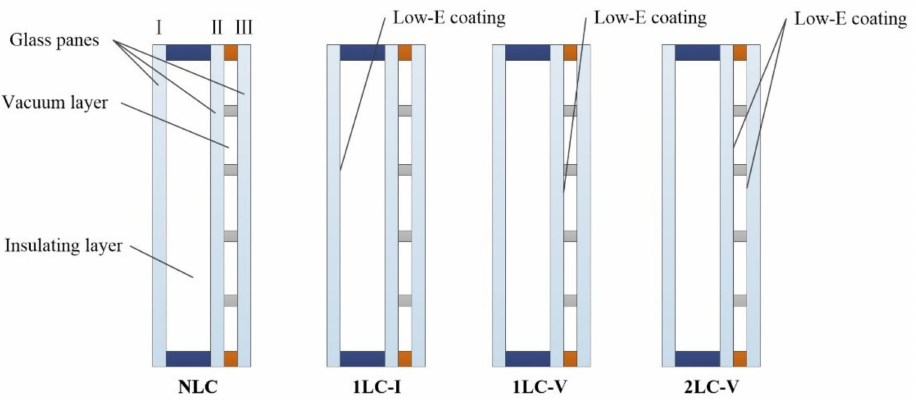
Figure 5. The location of Low-E coatings in the four model scenarios.